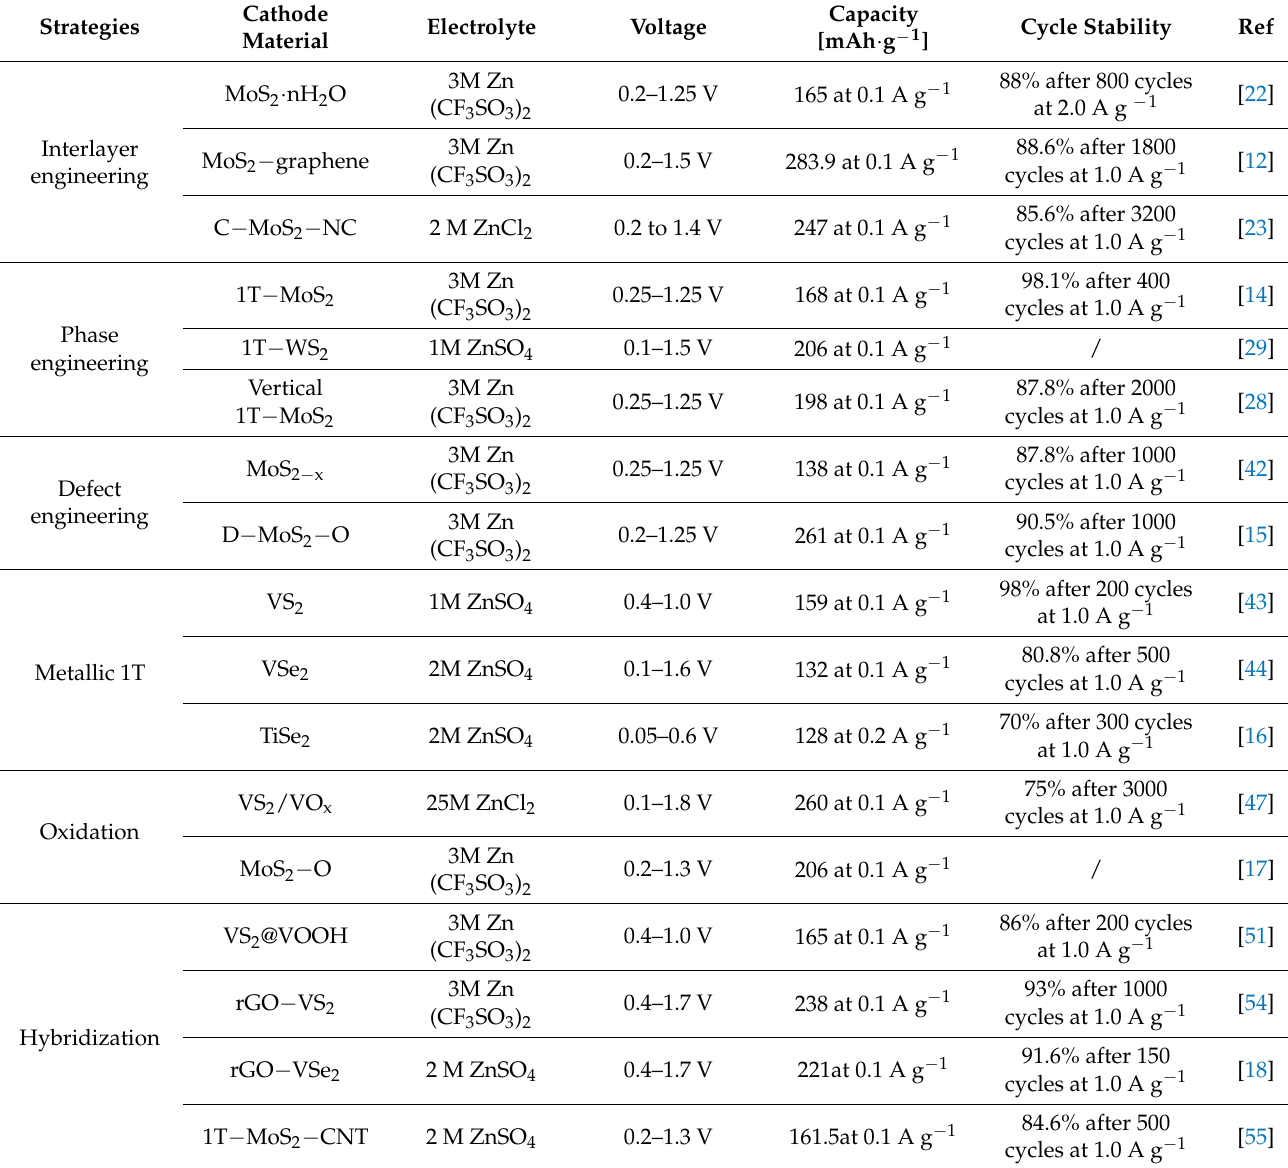
Table 1. Summary of the electrochemical performance of TMDs as ZIB